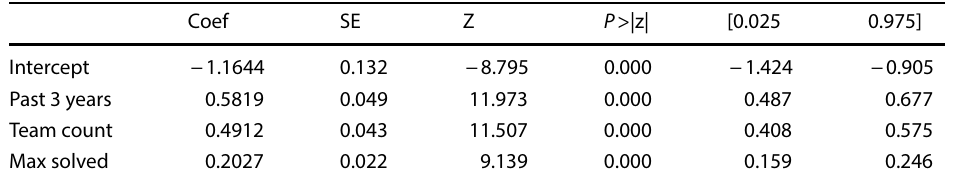
Fig. 5 Empirical cumula- tive distribution function of contests and percentage of teams in contest solving